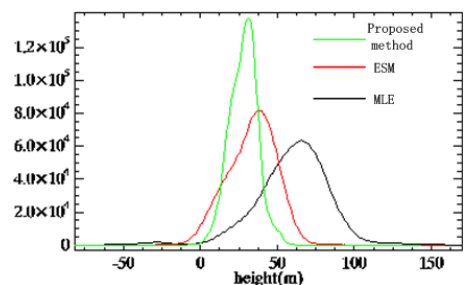
Figure.10. Surface height histograms of three